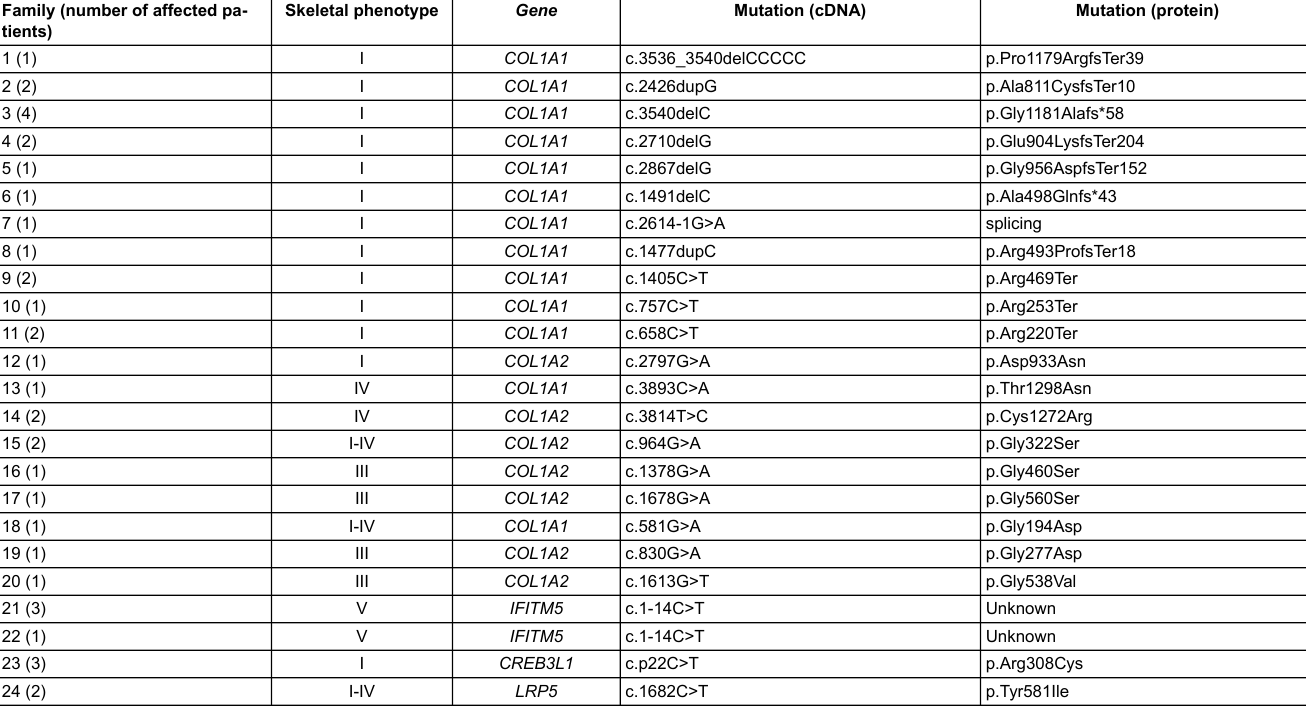
Table 2: Phenotype and genotype of 38 patients from 24 families followed up from the osteogenesis imperfecta group. Family (number of affected pa-